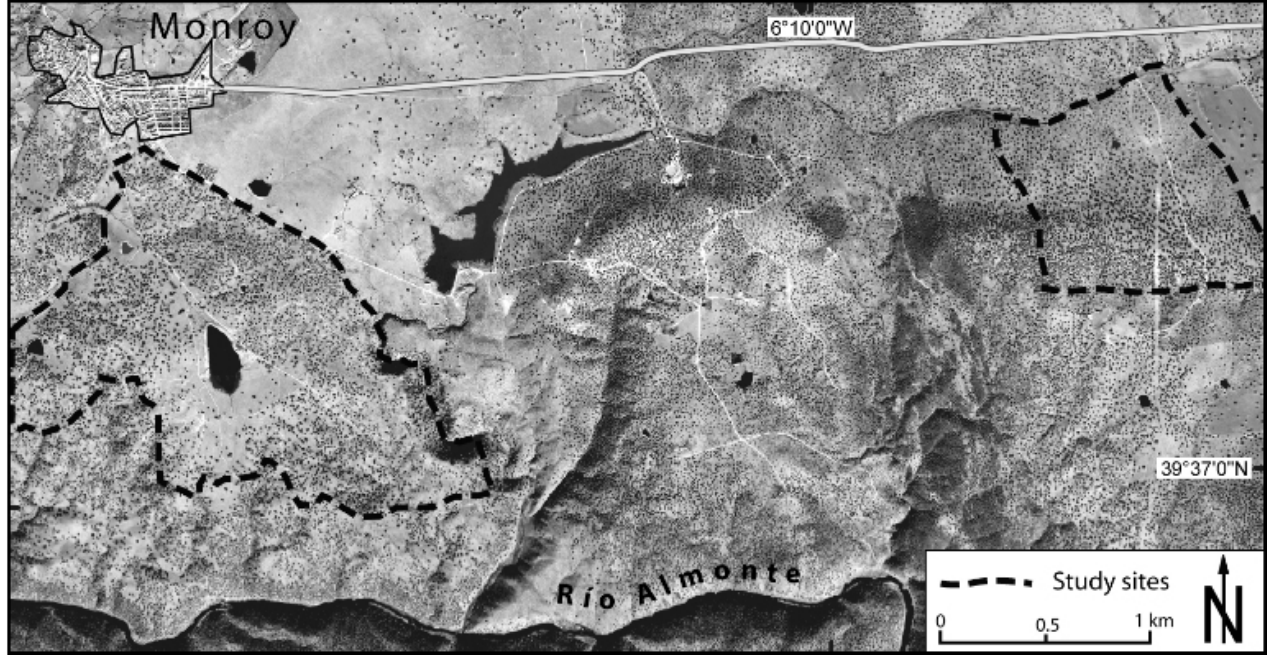
Fig. 1 . Location of the Dehesa Boyal (DB) site in the west and the Parapuños de Doña María (PA) site in the